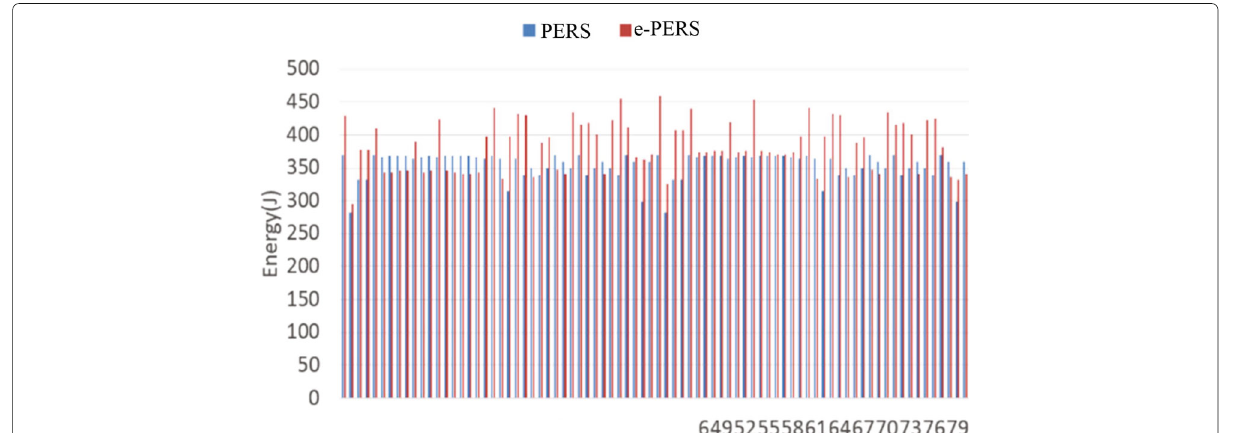
Fig. 12 The remaining energy of sensors at the end of the